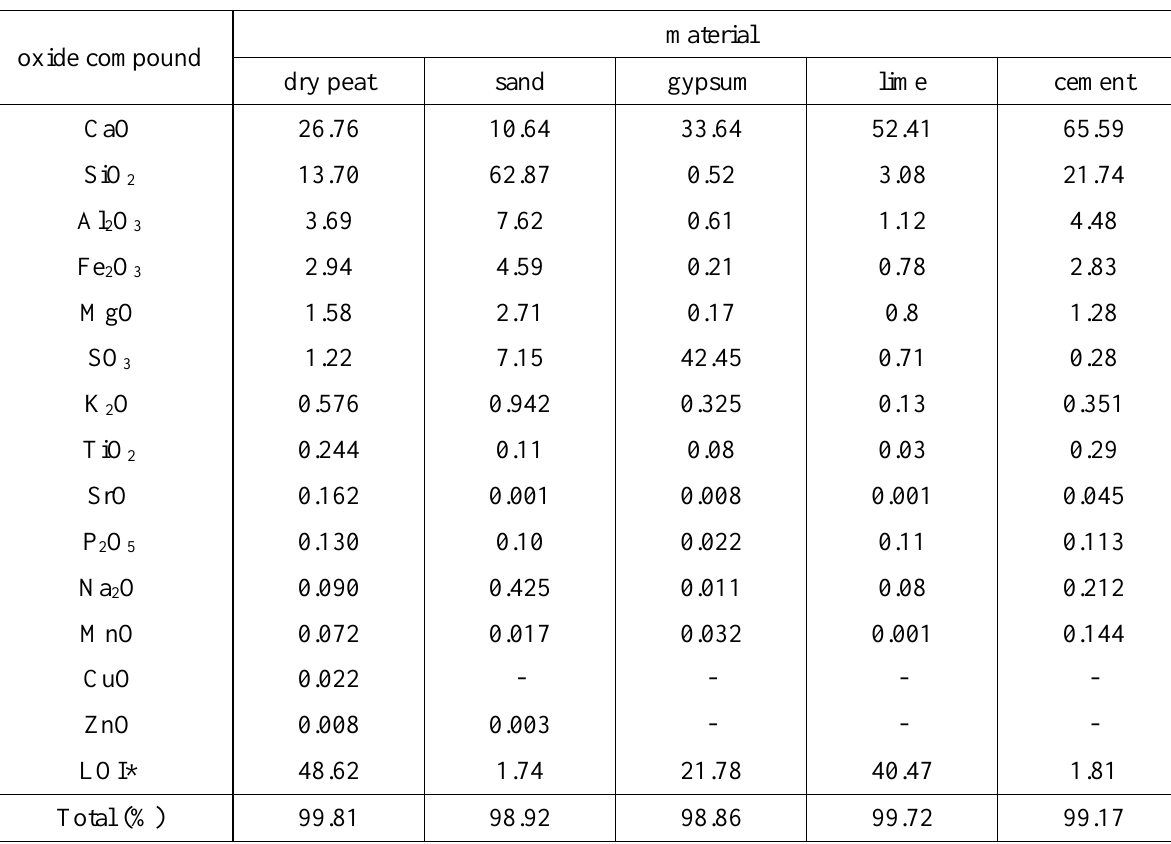
Table 6. Content (% by weight) of oxide compounds in dry peat, sand and the three pozzolanic additives tested in this study, determined by X-ray fluorescence (XRF). *Loss on ignition (LOI) (2 hours at 1000 °C) is also